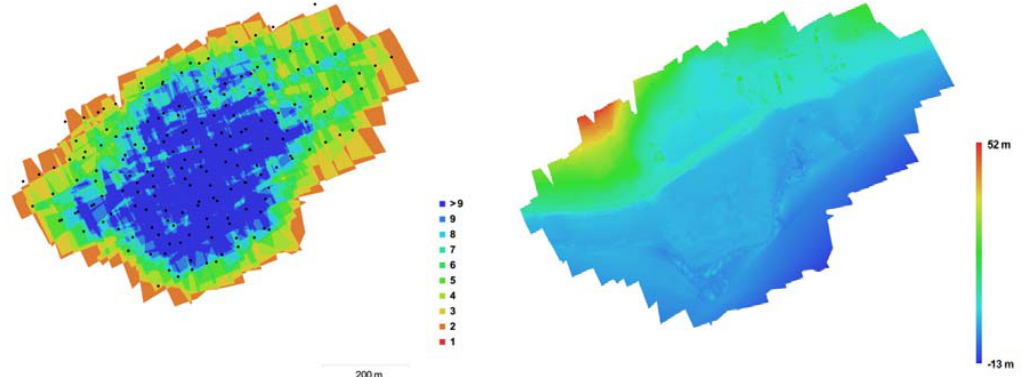
Figure 12. Amathounta test site: camera locations and photo overlap ( left ) and reconstructed digital elevation model ( right ).